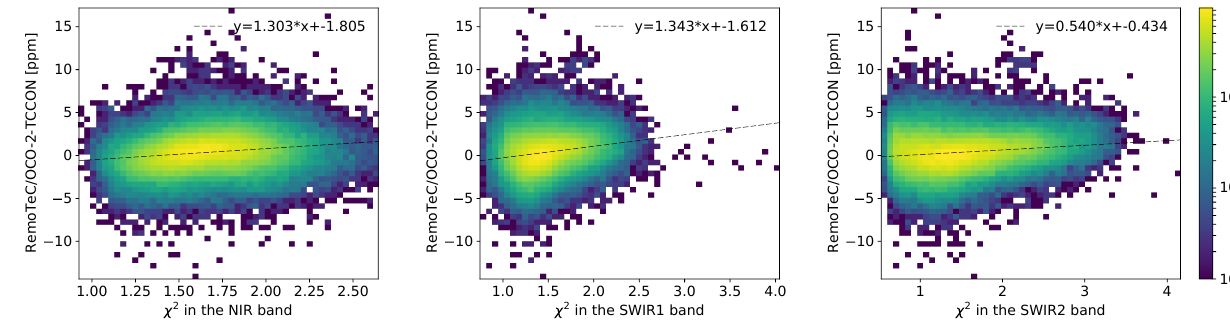
Figure 4. Error on X CO retrievals as a function of the goodness of fit in the NIR, SWIR-1 and SWIR-2 bands. Different colors represent the 2 frequency of point occurrence. The dashed line is a linear regression fit to the data.